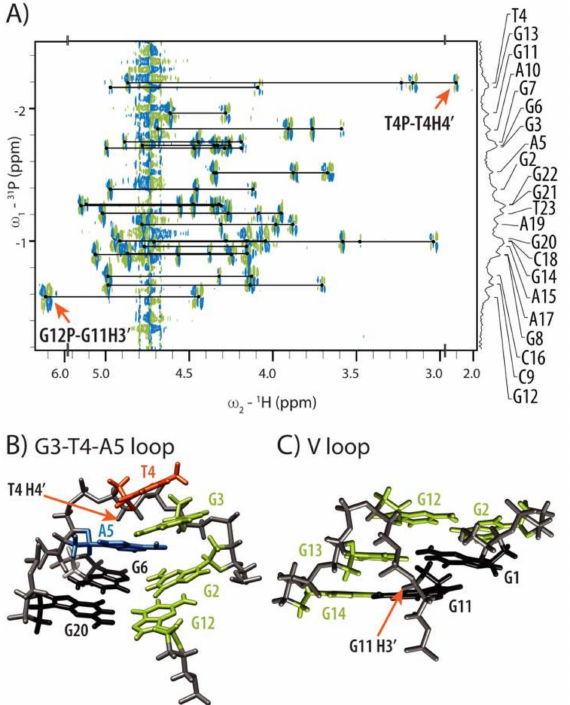
Figure 4. HP-COSY spectrum and structural details of G3-T4-A5 edgewise and no-residue V loop. ( A ) HP-COSY spectrum with assignment of phosphorus resonances in 1D 31 P spectrum. ( B ) Close-up of G3-T4-A5 edgewise loop shows proximity of H4 (cid:48) proton of T4 residue to aromatic ring of A5. ( C ) Perusal of V loop shows position of H3 (cid:48) proton of G11 residue. Colour scheme used is the same as in Figure